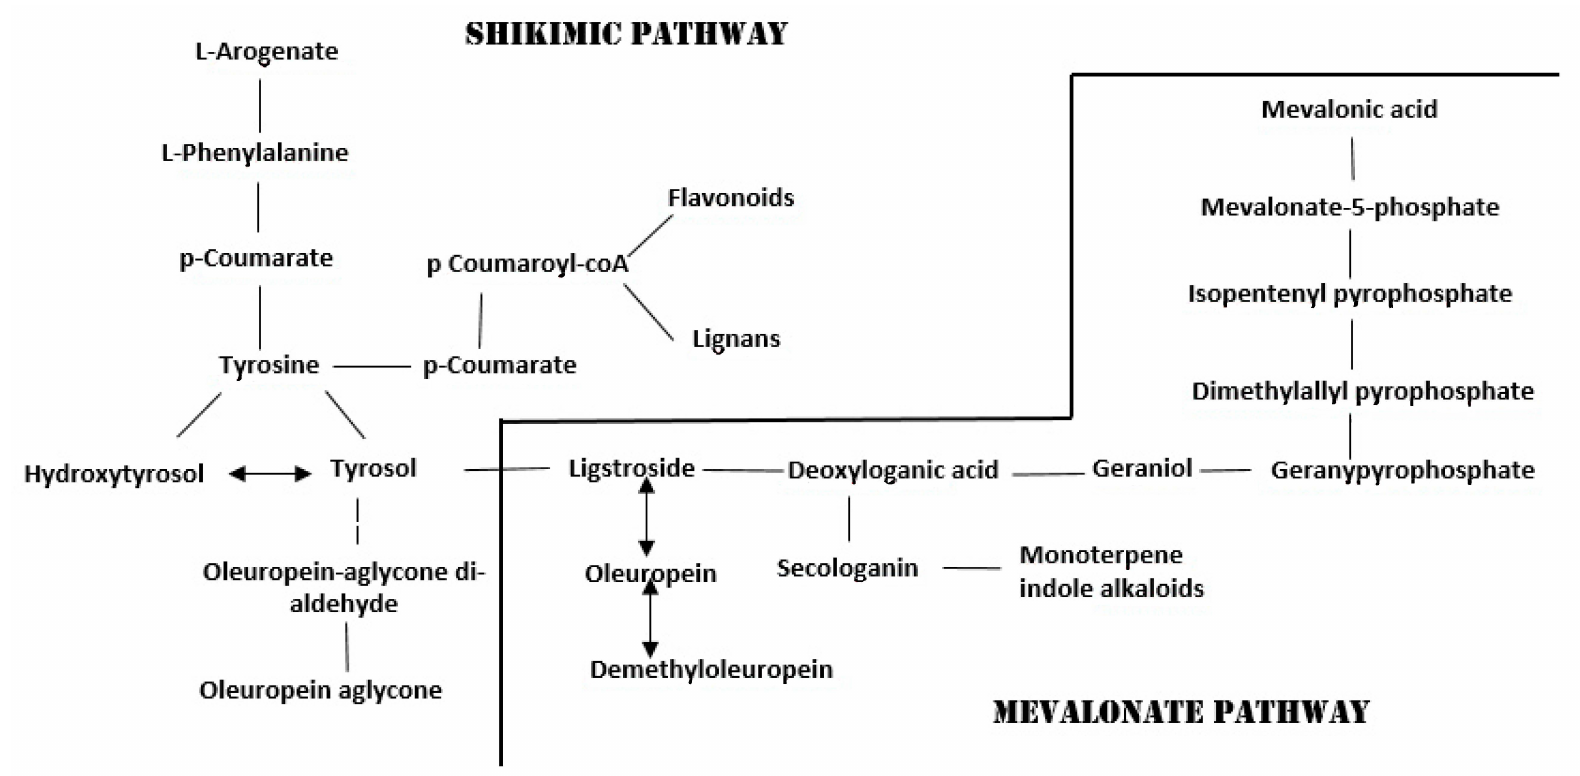
Figure 1. Secoiridoids biosynthesis